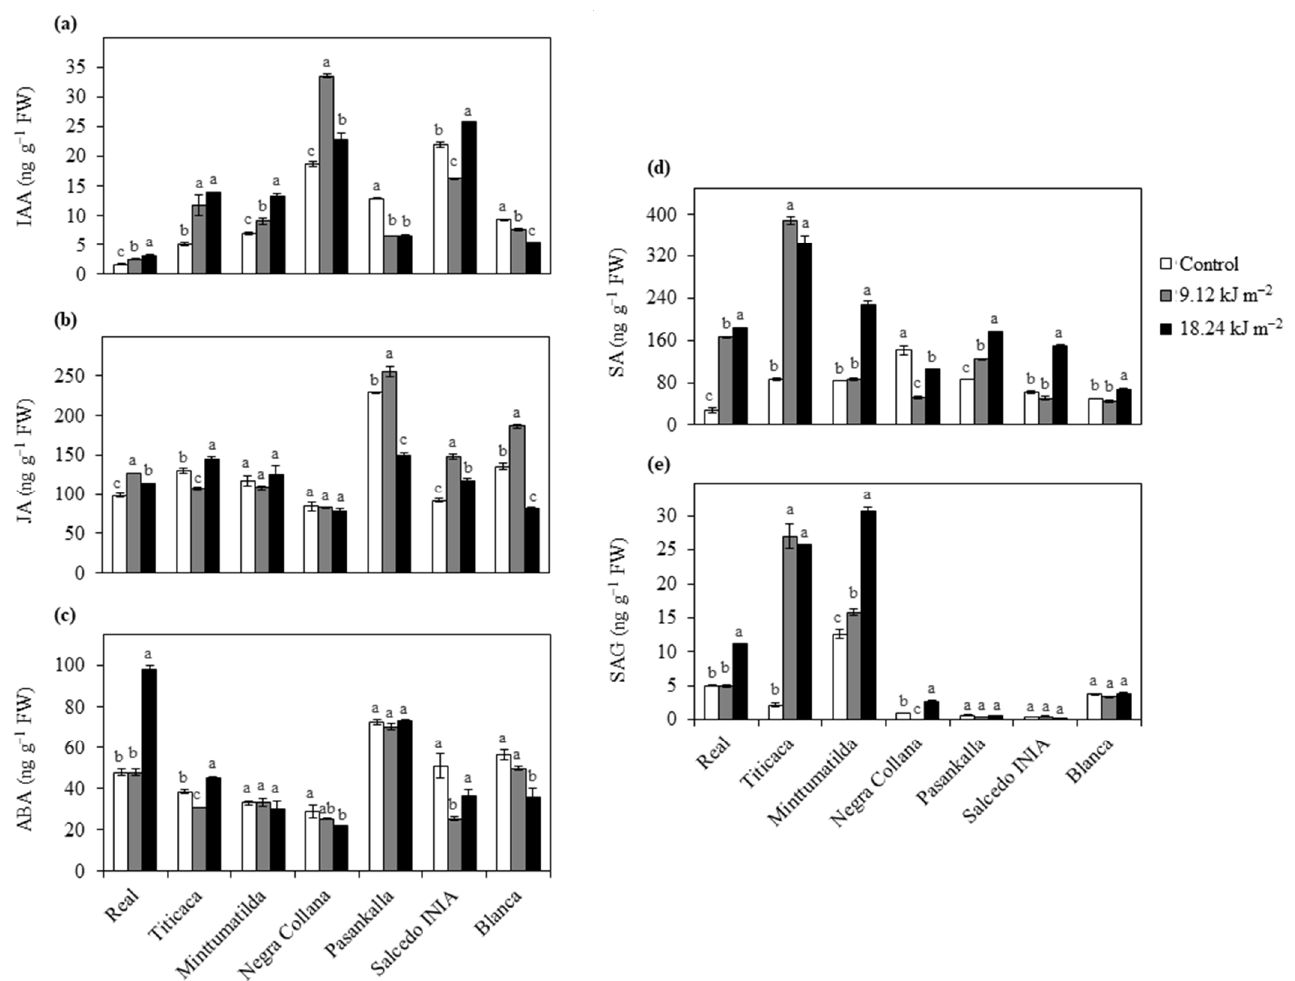
Figure 3. Effects of UV-B on plant growth regulators. Different quinoa varieties were exposed to 0 (Control), 9.12 and 18.24 kJ m − 2 UV-B. Hormones (ng g − 1 FW) including IAA ( a ), JA ( b ), ABA ( c ), SA ( d ) and SAG ( e ) were evaluated in leaves at 3 days of treatment. Error bars represent the standard error of the mean (n = 3). Different letters indicate significant differences between means within the same variety ( P < 0.05, Tukey’s test). IAA, indoleacetic acid. JA, jasmonic acid. ABA, abscisic acid. SA, salicylic acid. SAG, salicylic acid glucoside. FW, fresh weight.